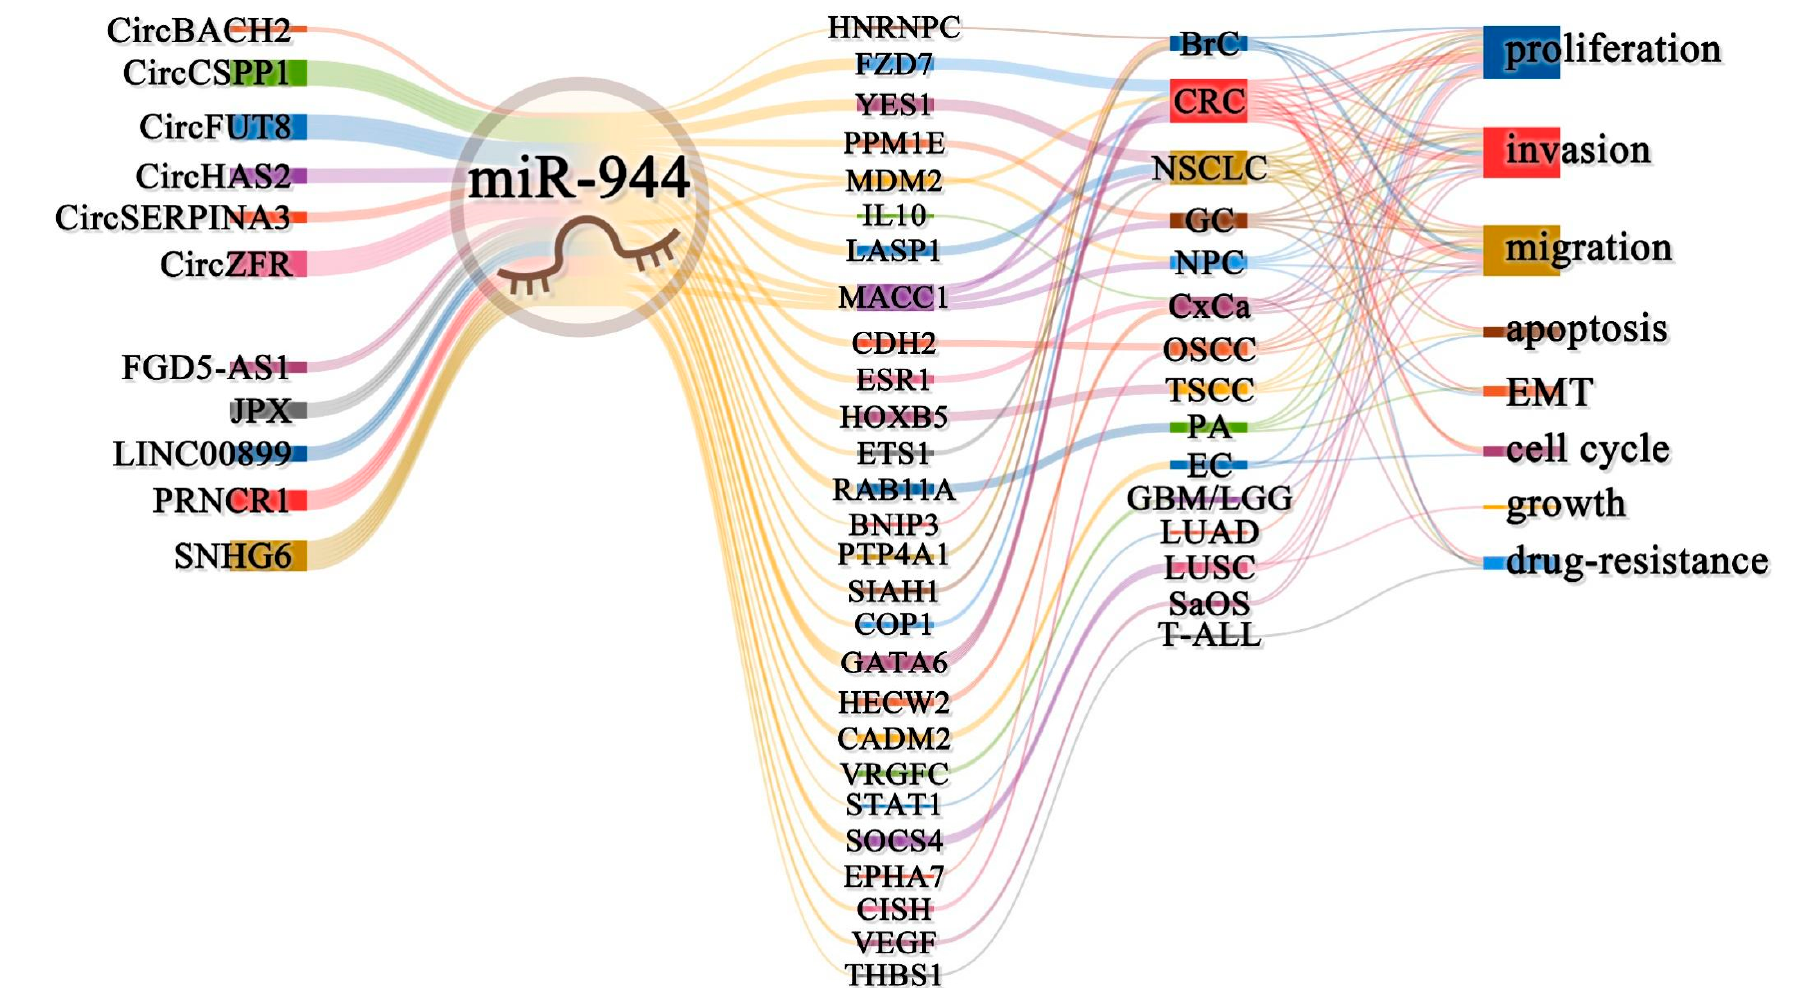
Figure 4. The ceRNA networks of miR-944. The ceRNA networks of miR-944 involve 11 ceRNAs and 27 protein-coding genes. It can regulate a variety of cancer cell biological behaviors, such as proliferation, invasion, migration, apoptosis, drug resistance, EMT, growth, and cell cycle in 16 cancers.